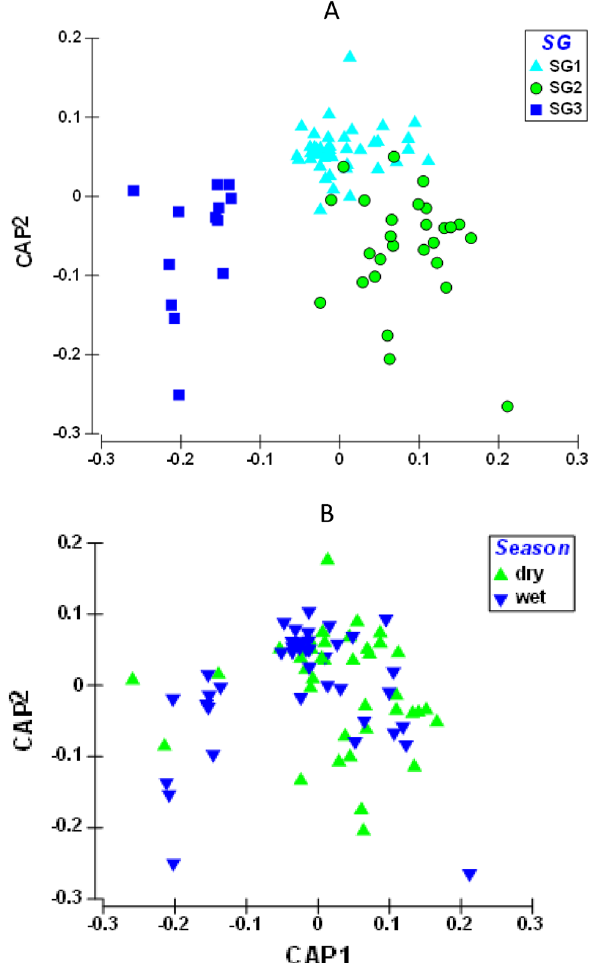
Figure 2. Canonical analysis of principal coordinates (CAP) ordination plot showing the clustering of site groups ( A ) and seasons ( B ) based on the physicochemical variables during the study period (2008–2012). SG1 Site group 1 (Site 1 = Adofi, Site 2 = Oleri, and Site 3 = Anwai upstream, Site 4 = Anwai downstream and Site 9 = Ogba upstream site), SG2 Site group 2 (Site 5 = Ethiope upstream, Site 6 = Ethiope downstream, Site 7 = Obosh and Site 8 = Ogba downstream) > SG3 Site group 3 (Site 10 = Orogodo and Site 11 = Warri River).